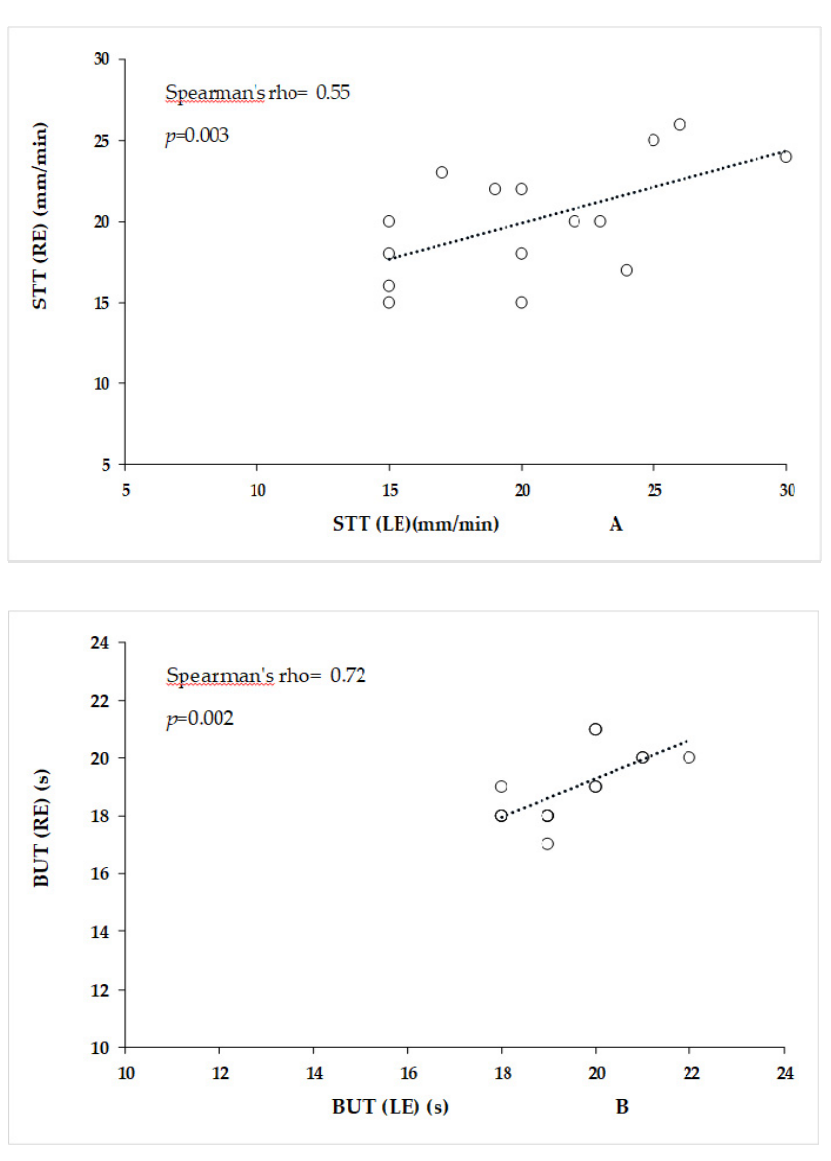
Figure 2. Shirmer tear test (STT-1) ( A ) and break up time (BUT) ( B ) correlations between the right (RE) and left eyes (LE).